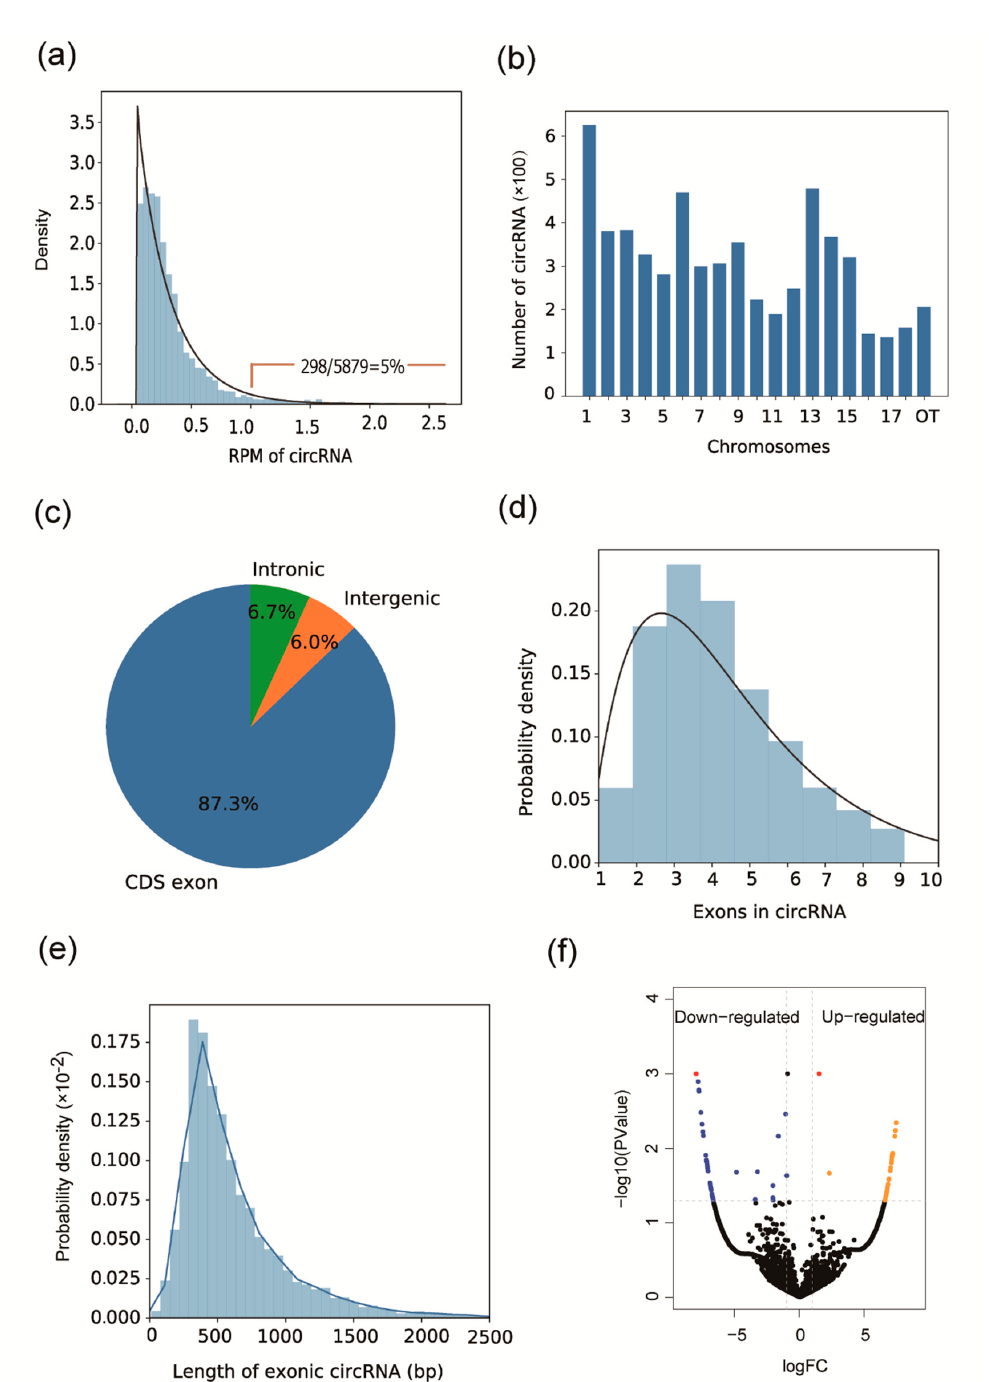
Figure 1. Circular RNAs (CircRNA) characteristics and volcano plot. ( a ) The distribution of Reads Per Million (RPM) for circRNAs. ( b ) The genomic location of circRNA in porcine chromosomes. Others (OT) represent a circRNA that was on scaffold and had not been assigned a chromosome. ( c ) Categories of circRNAs based on their genomic origin. ( d ) Distribution of the exon numbers of circRNAs. ( e ) Distribution of exonic circRNA length. ( f ) Volcano plot of di ff erentially expressed circRNAs (DECs). The blue and orange dots represent down- and up-regulated circRNA, respectively. The red point represents DECs with a straight cuto ff of [ | log10(FC) | ≥ 1, p ≤ 0.05, and FDR ≤